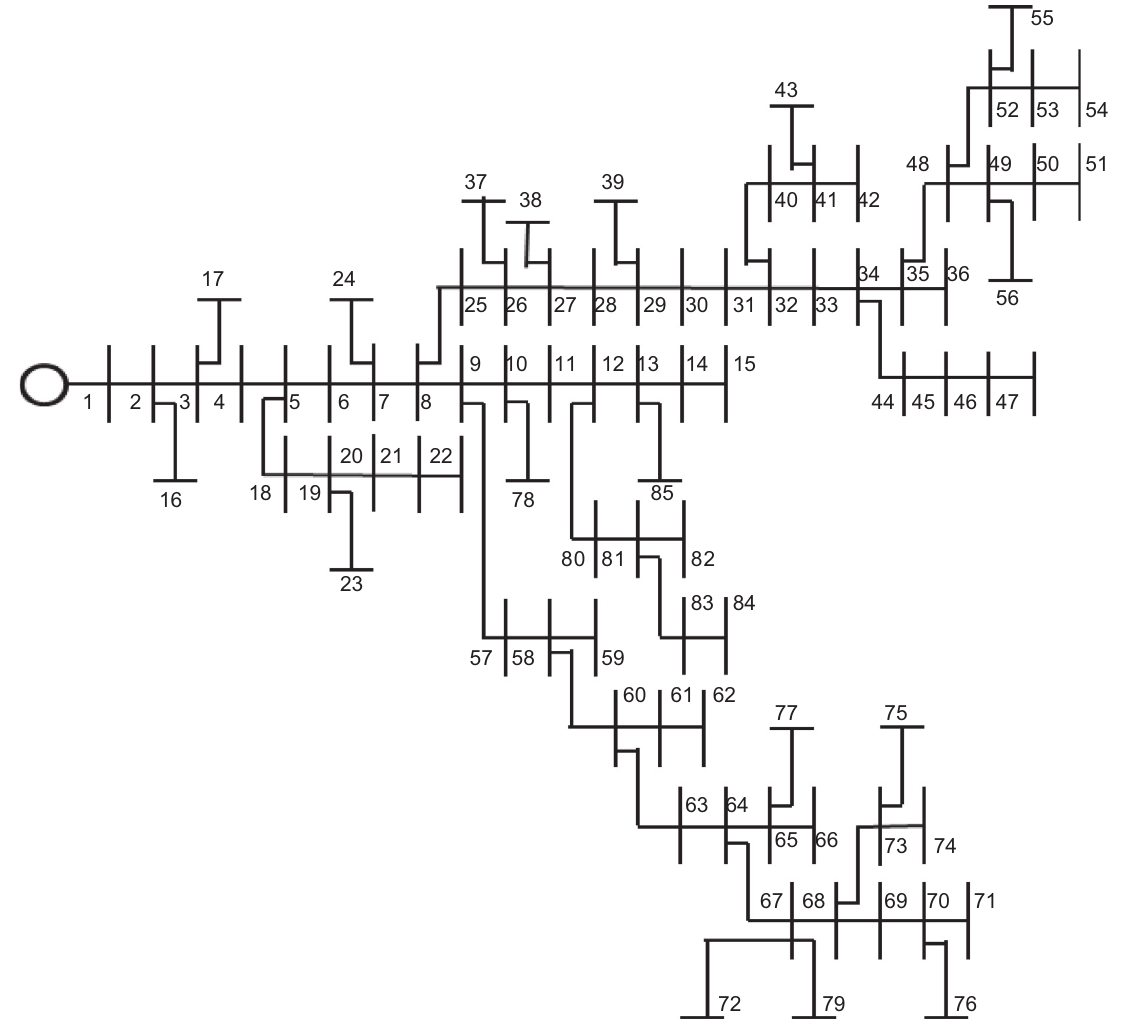
Figure 9 IEEE-85 bus radial distribution test system. Figure 2. Schematic interconnection among nodes in the IEEE 85-bus system. Table 3. Parametric information regarding the IEEE 85-bus